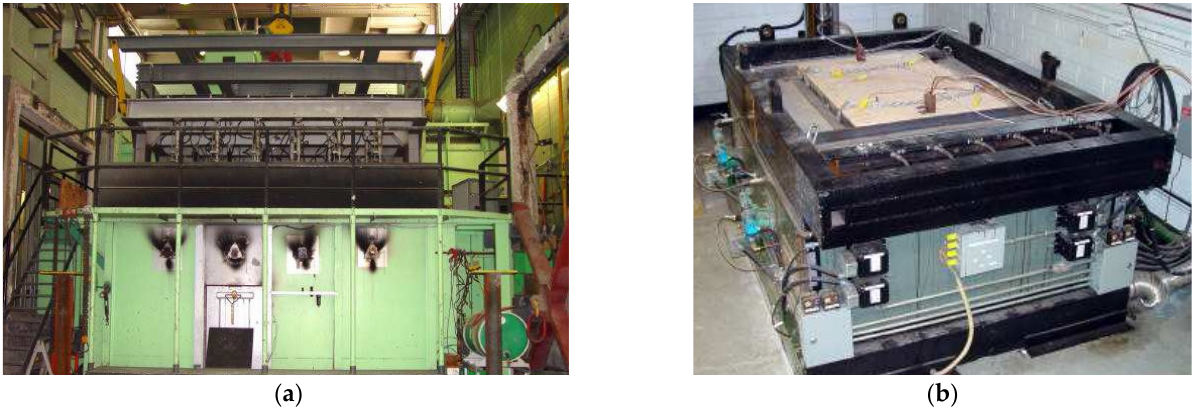
Figure 19. ( a ) Full ‐ scale floor furnace and ( b ) intermediate ‐ scale floor furnace. Nassif et al. presented the experimental observations and outcomes of a full ‐ scale fire ‐ resistance test on a partition wall. The partition wall was built within a concrete frame and exposed to the standard fire test. The partition wall was made with C ‐ section steel studs, with gypsum boards fixed on both sides, and the wall craters were filled with rock wool insulation. It was observed that the full ‐ scale fire ‐ resistance test gives detailed ther ‐ mal profiling throughout the partition wall. The setup for the large ‐ scale fire ‐ resistance test of the partition wall utilized in the study is shown in Figure 20 [55].